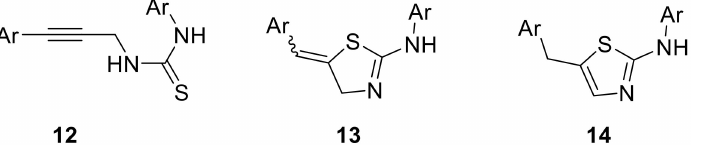
Figure 1. Structure of thiazolines 13 and thiazoles 14 derived from propargylic thioureas 12 . To this end we treated a solution of the respective propargylic amine 2 (0.5 M, MeCN) with stoichiometric amounts of suitable aryl isothiocyanates ( 11 ). The expected thiourea intermediate 12 formed within 30 min and upon addition of acid (HCl or TFA, 1.0 equiv.) smoothly converted into the heterocyclic target structures within a short time (Scheme